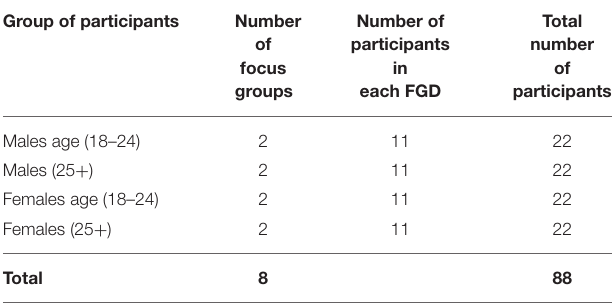
TABLE 1 | Selected participants and number of